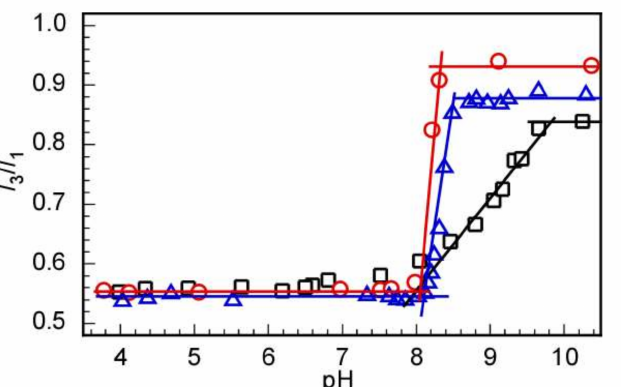
Figure 3. Fluorescence peak intensity ratio ( I 3 / I 1 ) of pyrene in the presence of (MPC/DPAEMA50) 107 ( (cid:3) ), PMPC 52 - b -PDPAEMA 56 (o), and their equimolar mixture ( ∆ ) in 0.1 M NaCl at a total polymer concentration of 1.0 g/L as a function of the solution pH.